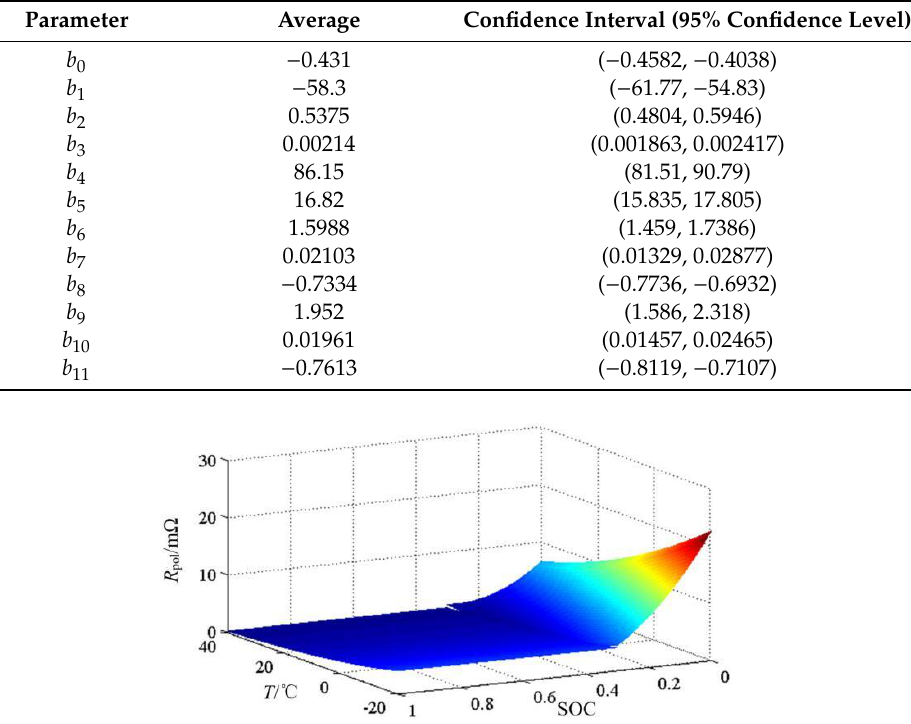
Figure 6. Relationship among fitted R pol and SOC, T .